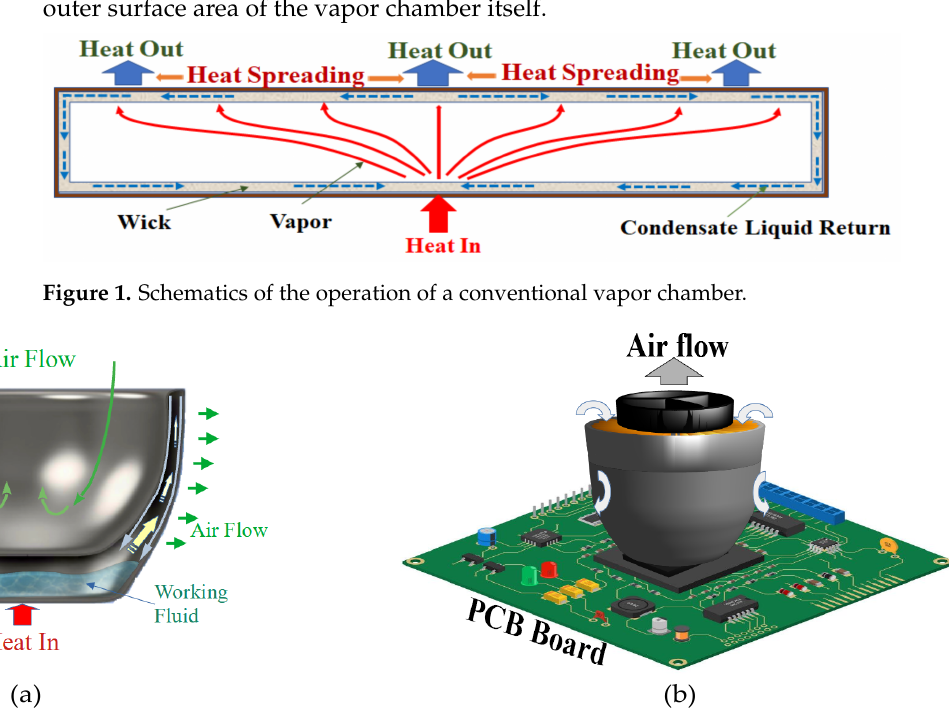
Figure 2. Principle of the hemispherical shell vapor chamber. ( a ) Working principle; ( b ) Conceptional sketch for electronics cooling.